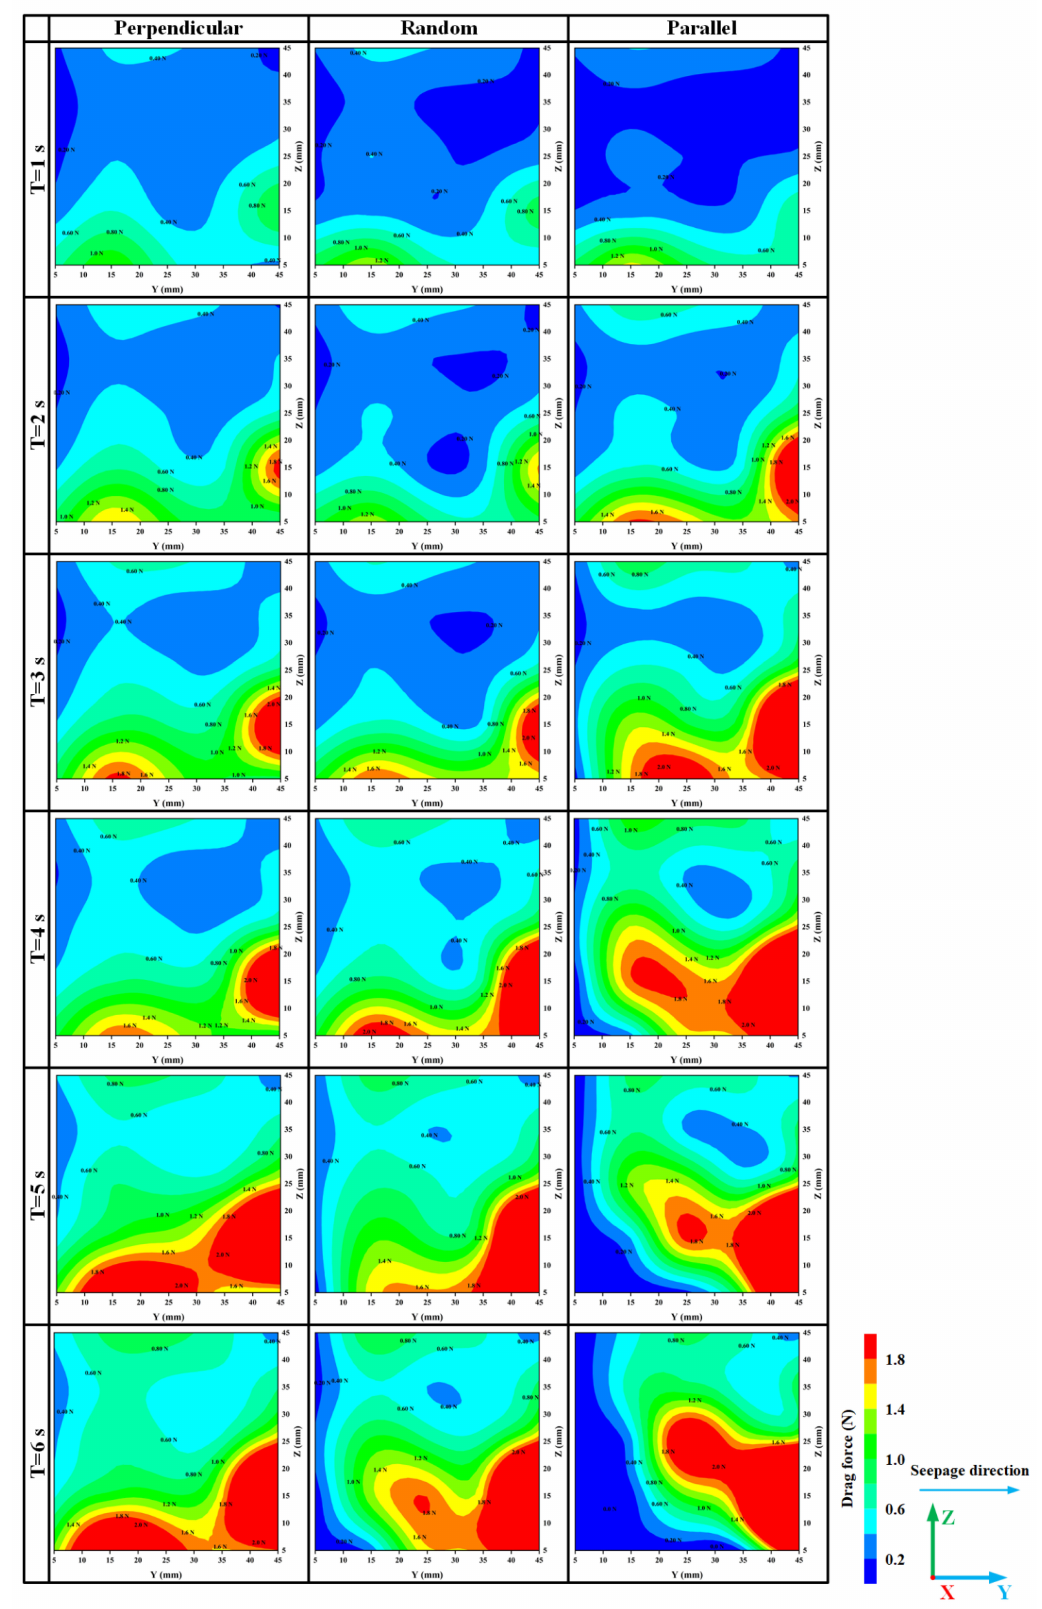
Figure 10. Evolution of the distribution of drag force in the vessel YZ plane with